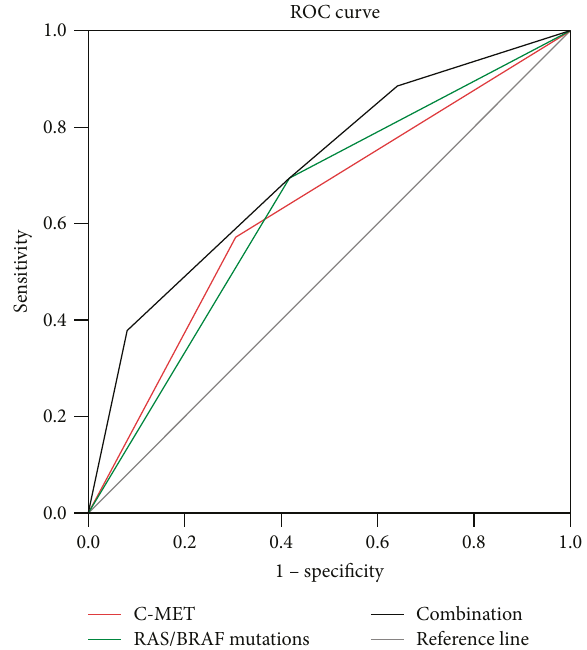
Figure 3: ROC curves for the predictive value of RAS / BRAF mutations and C-MET expression for brain and/or lung metastasis. ROC: receiver operating characteristic